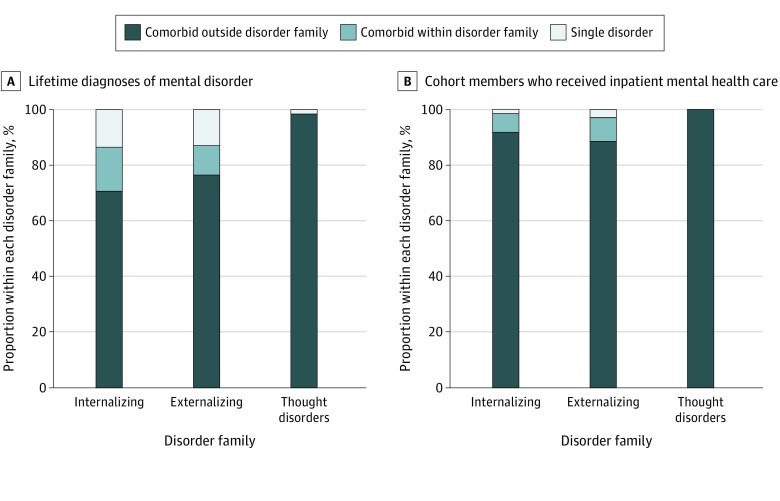
Lifetime Diagnoses of Single and Comorbid DisordersA, Information about the 869 participants who were ever diagnosed by the study with a mental disorder; 712 met criteria for an internalizing disorder, 625 met criteria for an externalizing disorder, and 177 met criteria for a thought disorder. Each bar is divided according to whether, over the course of their lifetime, participants also met criteria for another disorder outside that family of disorders, met criteria for another disorder within that family of disorders, or met criteria for just a single disorder. B, Same analysis restricted to the 83 cohort members who received inpatient mental-health services: 74 met criteria for an internalizing disorder, 70 met criteria for an externalizing disorder, and 41 of 83 met criteria for a thought disorder.